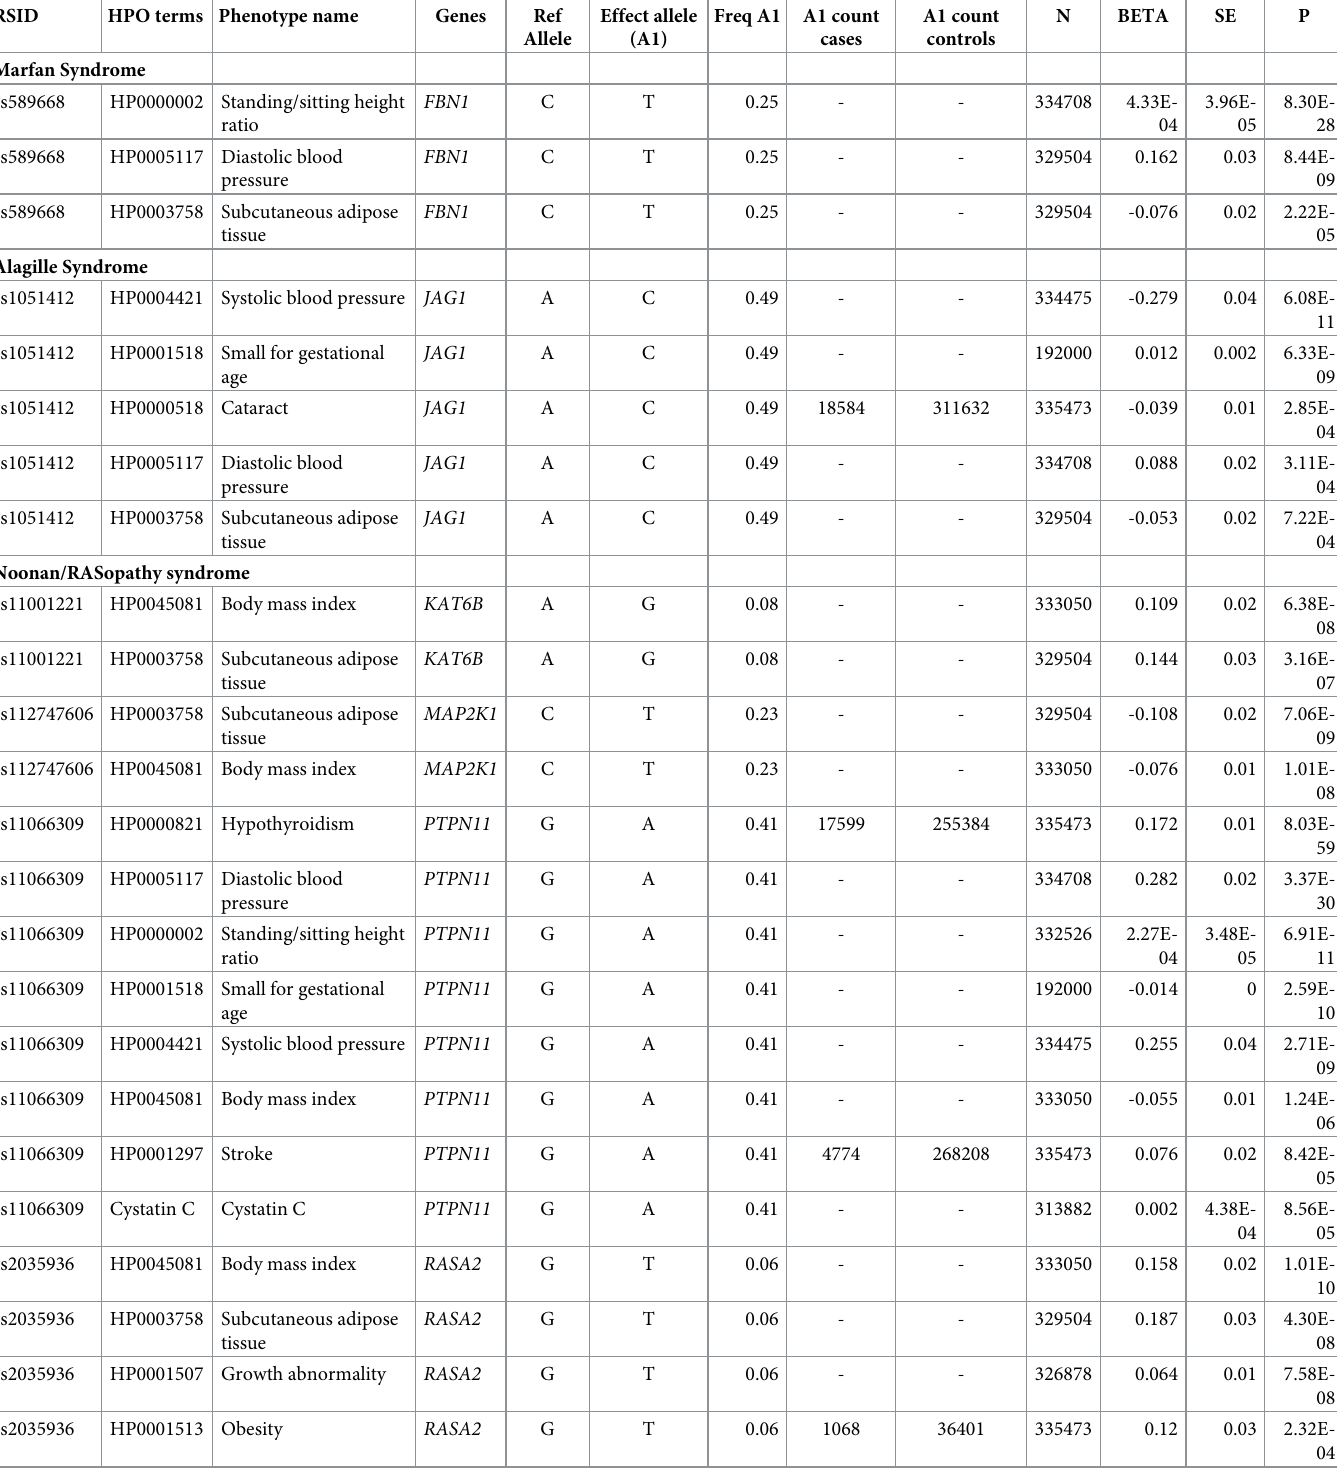
Table 1. Table of association between the top SNPs with multiple phenotypes in each gene and significant (p-value < 2.7x10-07) or suggestive (p-value < 1x10-04) associations with HPO phenotypes (A1 corresponds to the effect allele).